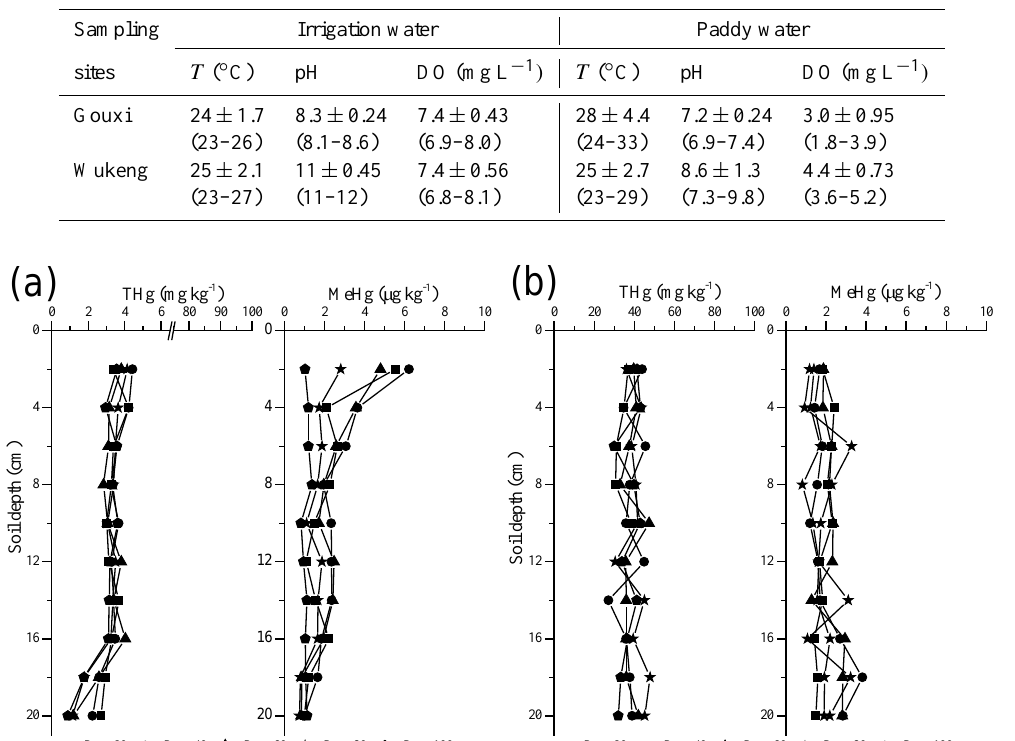
Figure 4. Concentration of THg and MeHg in soil cores during the rice growing season on Days 20, 40, 60, 80, and 100: ( a ) artisanal Hg mining site of Gouxi; (b) abandoned Hg mining site of